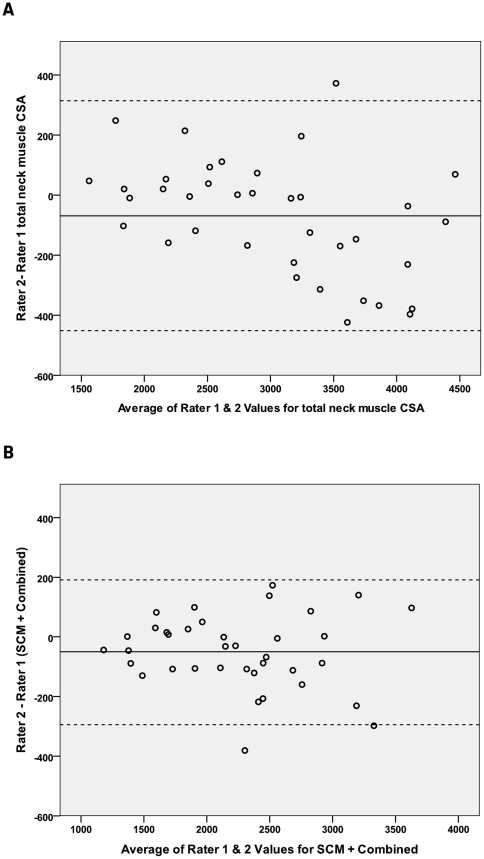
Bland-Altman plots for total neck muscle CSA and SCM+combined CSA measured by 2 raters.Bias of measurement between 2 different raters (mean of the ordinate) and limits of agreement (2sd) are represented by a solid and two dashed lines respectively. A. Bland-Altman plot for measurements of total neck muscle CSA by 2 different raters. B. Bland-Altman plot for measurements of SCM+combined CSA by 2 different raters.